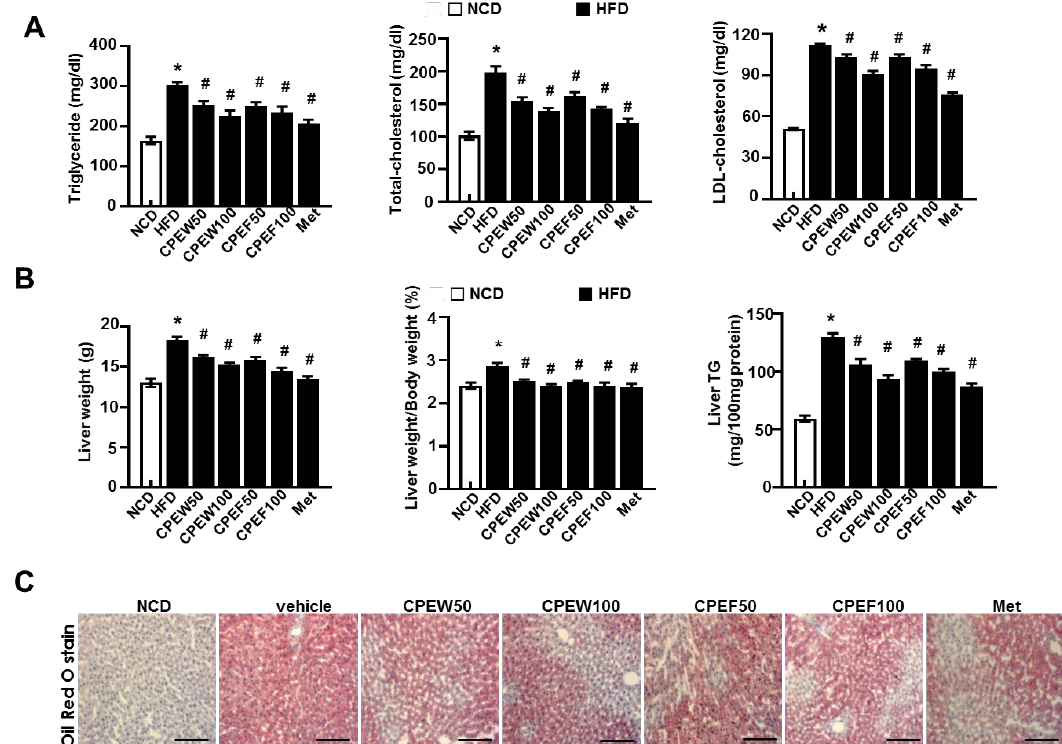
Figure 3. Citrus peel prevents HFD-induced hepatic steatosis. Rats were placed on either NCD or 60% high-fat diet for eight weeks and were supplemented with ultra-pure water, metformin (100 mg/kg), or one of the indicated concentrations of citrus peel (50 and 100 mg/kg). ( A ) Biochemical analysis of plasma samples. Levels of TG, TC and LDL-c were measured in the plasma of rat in different experimental groups. ( B ) Liver weight, and liver weight/body weight and liver TG content were measured 8 weeks after initial CPEW and CPEF administration. ( C ) Liver tissues were subjected to Oil Red O staining. Scale bars, 200 μm. Values are mean ± SEM. (n = 7~8, * P < 0.05 vs. NCD-group, # P < 0.05 vs. HFD-group). CPEW, citrus peel extract hot-air dry; CPEF, citrus peel extract